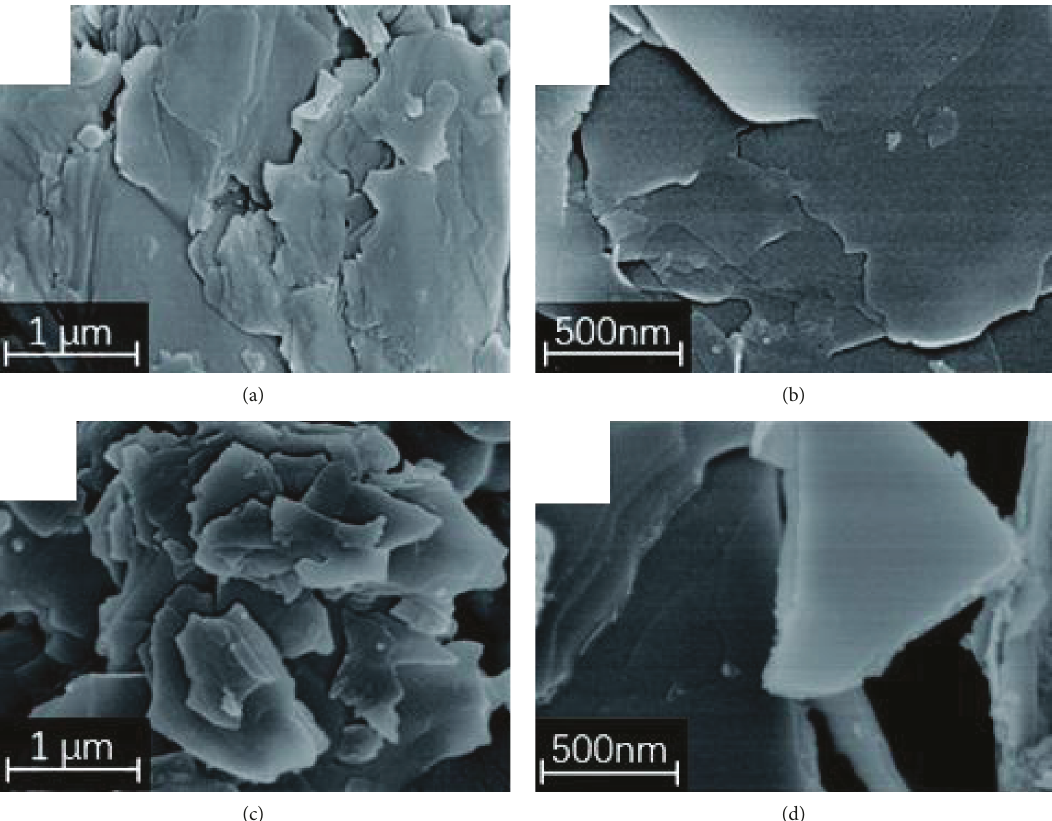
Figure 4: SEM images of (a, b) medical talc intercalated with TNBT (T-H) and (c, d) medical talc intercalated with TNBT after calcining at 400 ° C (T-H-400).